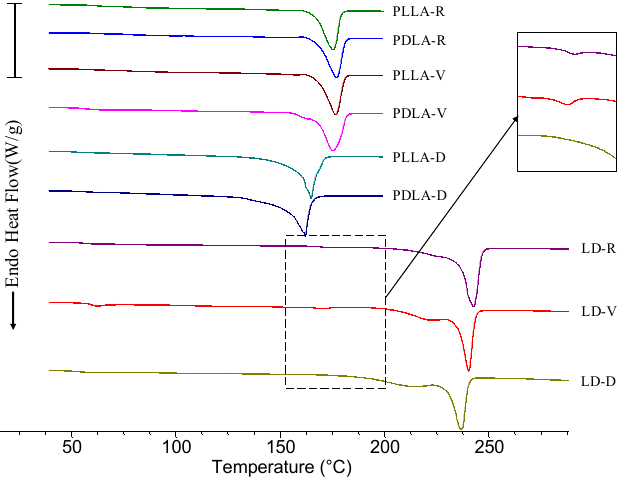
Figure 6. First differential scanning calorimetry (DSC) heating curves of PLLA and PDLA from 30 to 200 °C and those of the LD blend from 30 to 290 °C. The heating rate was 10 °C/min.